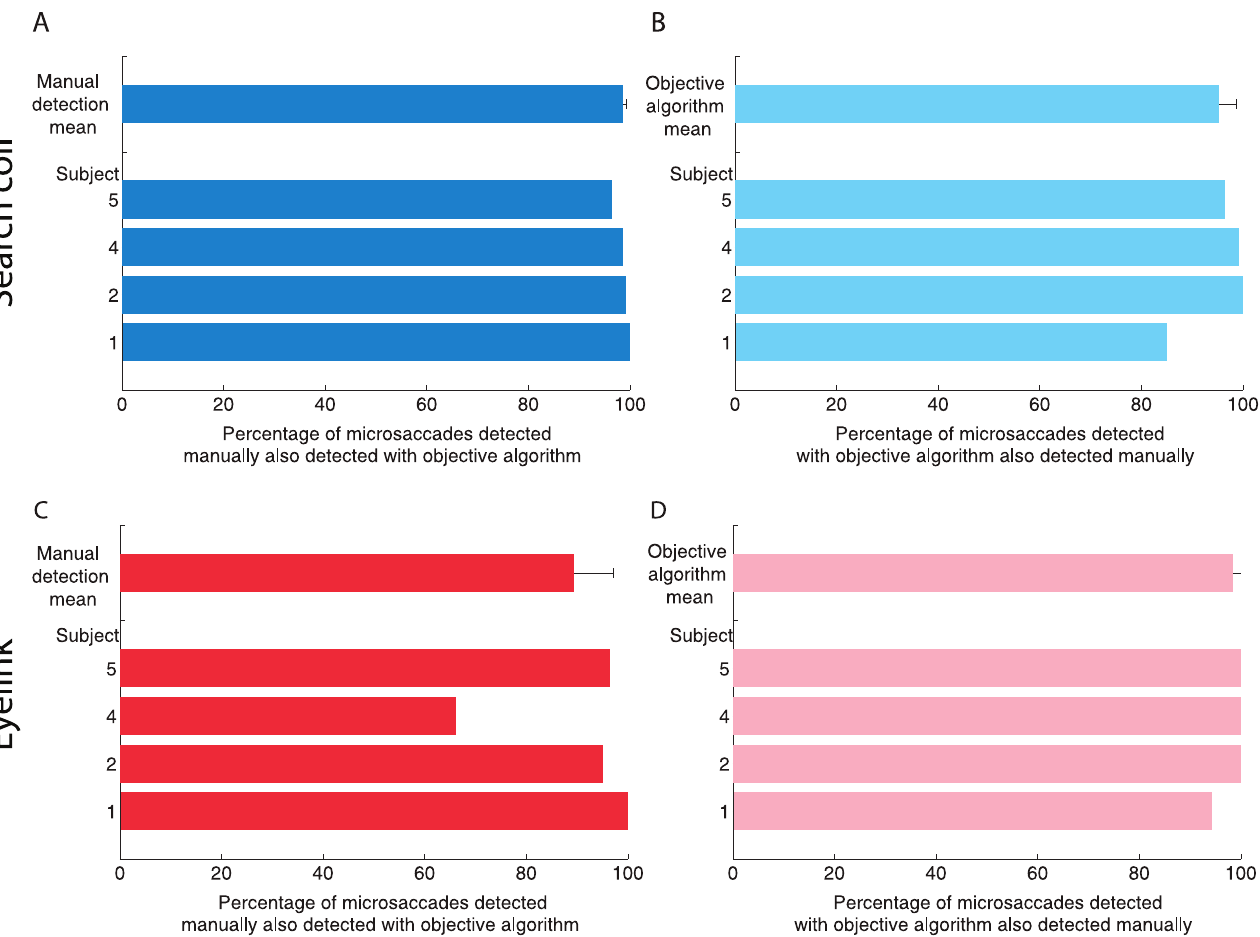
Fig 3. Coherence of detection between manually detected microsaccades and microsaccades detected with an objective algorithm, for the search coil (top row) and video tracker (bottom row) data. ( A ) Percentage of search coil microsaccades detected manually that were also detected with the objective algorithm. ( B ) Percentage of search coil microsaccades detected manually that were also detected with the objective algorithm. ( A ) Percentage of video tracker microsaccades detected manually that were also detected with the objective algorithm. ( B ) Percentage of video tracker microsaccades detected manually that were also detected with the objective algorithm. Error bars represent the S.E.M. across participants ( n = 4).